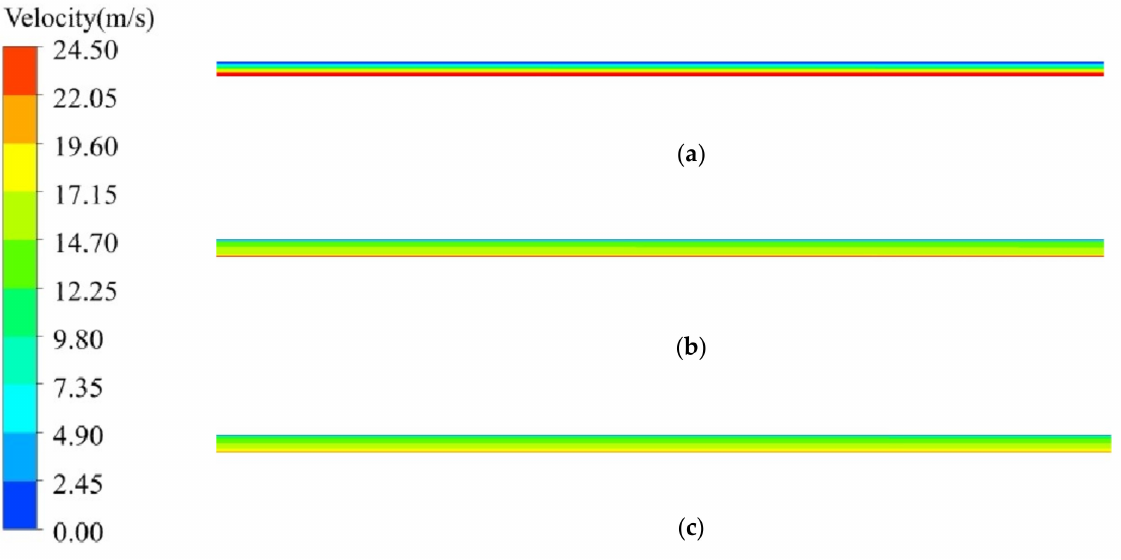
Figure 5. The velocity distribution of different grid nodes. ( a ) 3 nodes, ( b ) 11 nodes, ( c ) 21 nodes. Figure 6 quantitatively analyzes the velocity distribution at the stator–rotor cavity clearance with radial distance. Comparing the velocity distribution trends of different grid nodes, it is found that the velocity close to the rotor side is faster, and the velocity decreases gradually as the distance tends to the stator. The velocity distribution trends of the 3-node grid and the 11-node grid show a linear distribution trend. The speed variation from the stator side to the rotor side is small. According to the viscous characteristics of the fluid, the relative movement between the liquid layers produces shear stress; so, its